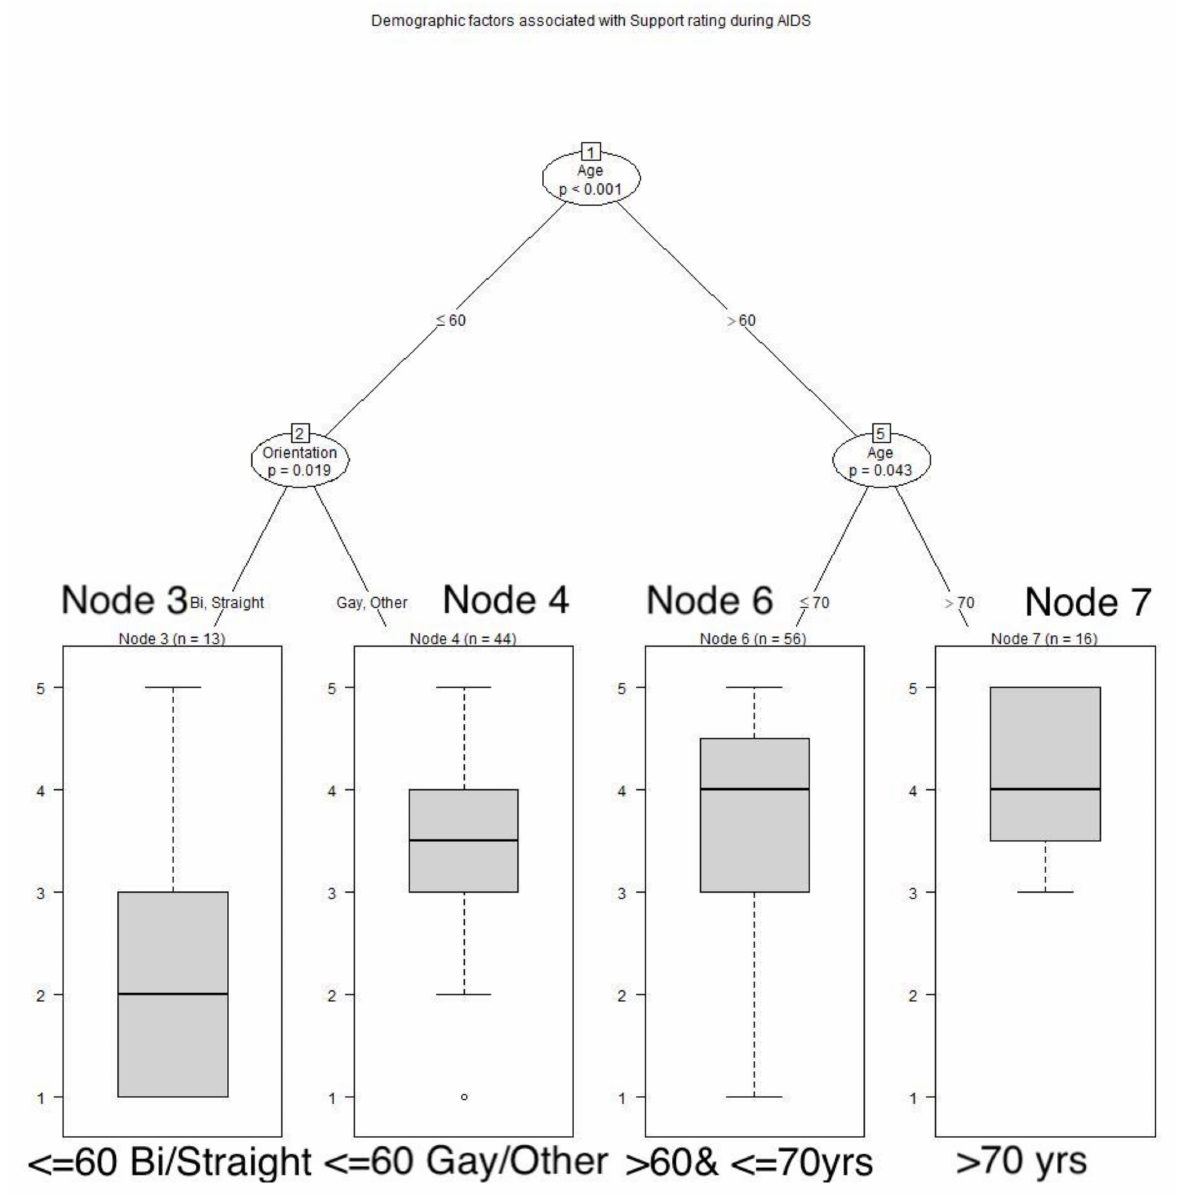
Figure 8. Demographic factors associated with ratings of human support during AIDS. Respon- dents over 60 years of age rated their human support more highly than younger respondents: those over 70 years of age gave even higher ratings; among younger respondents, gays gave higher ratings than straights: Node 3: x − = 2.308, SD 1.2506; Node 4: x − = 3.409, SD 1.272; Node 6: x − = 3.571, SD 1.1258; Node 7: x − = 4.125, SD